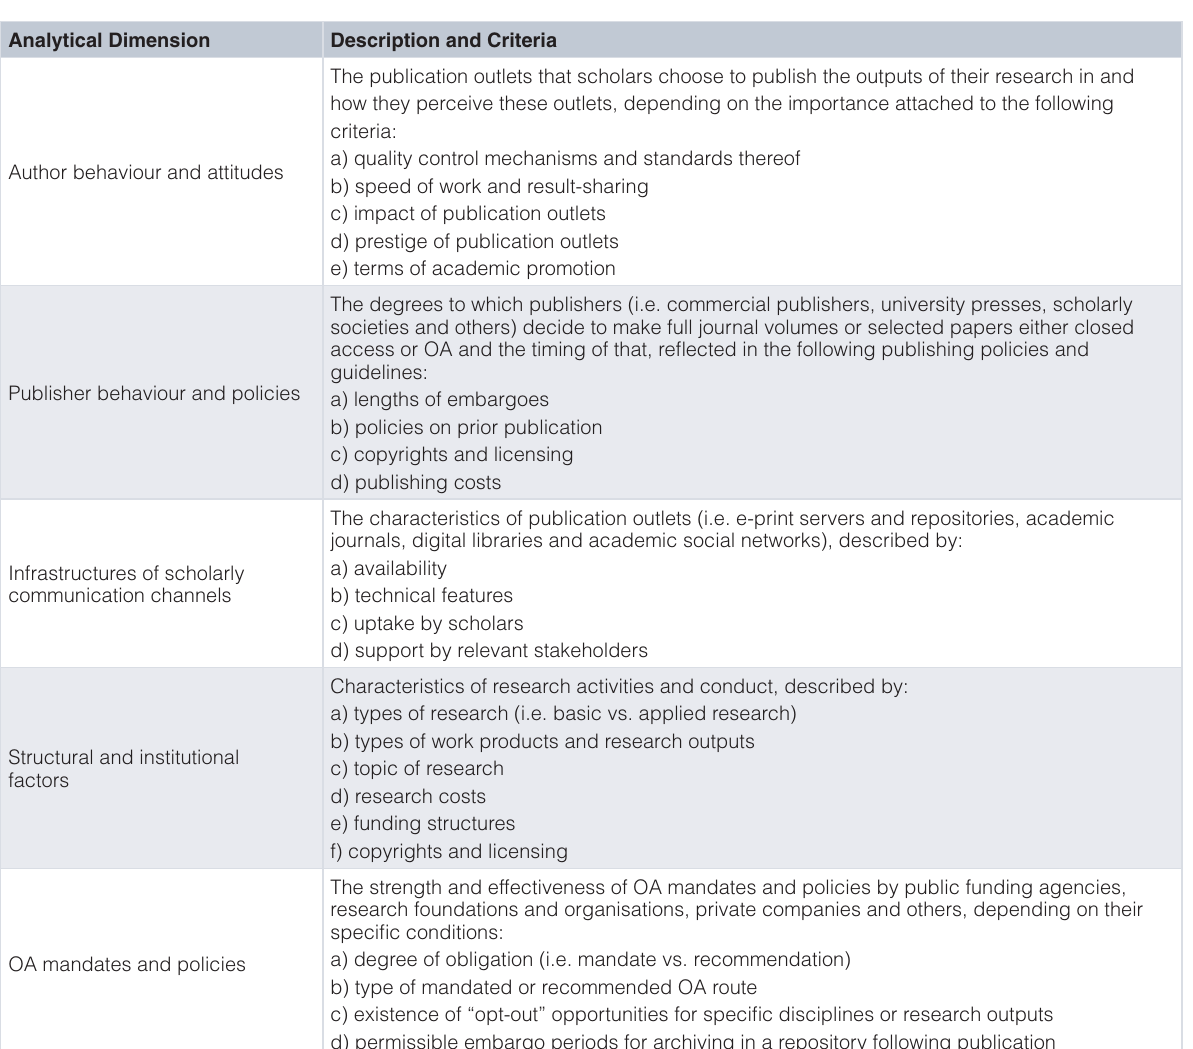
Table 5. Framework of